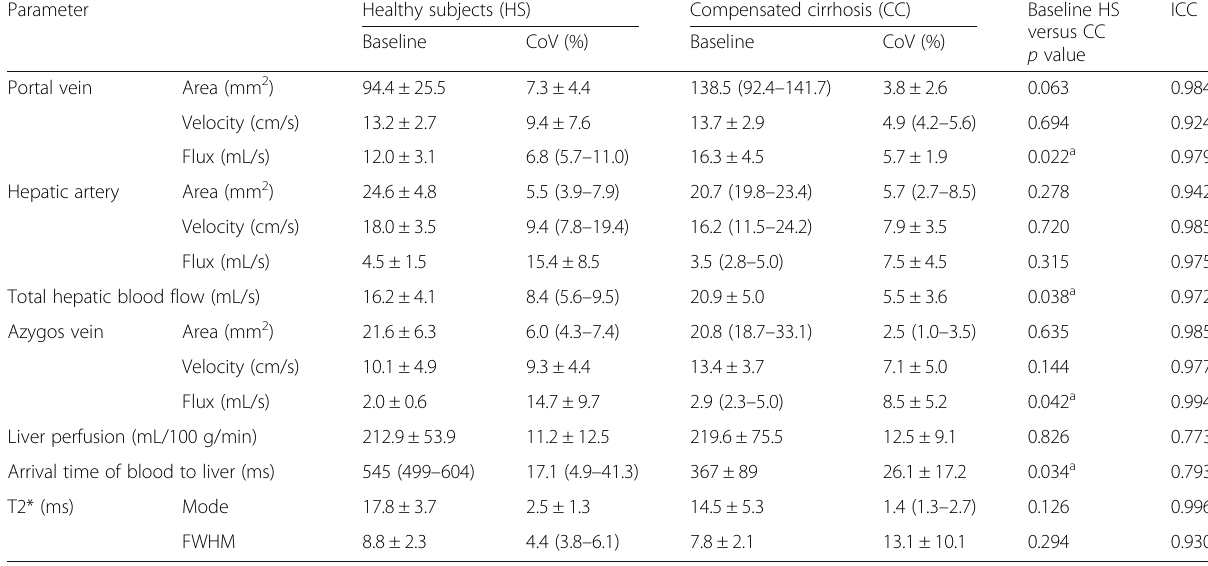
Table 3 Baseline magnetic resonance imaging flow, perfusion, and transverse relaxation time (T2*) data for healthy participants and patients with compensated cirrhosis (CC)